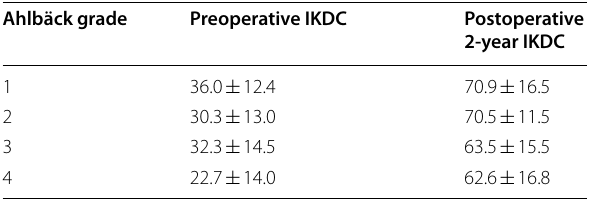
Table 7 Relationship between IKDC subjective score and